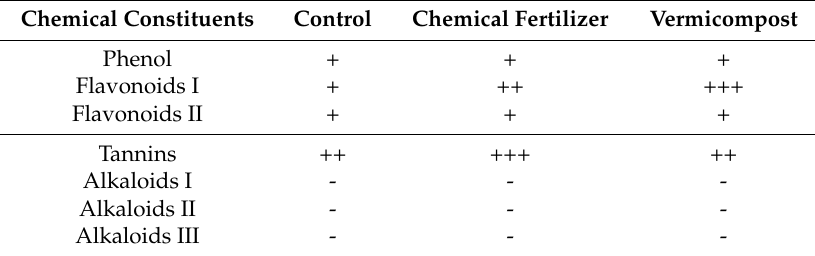
Table 1. Phytochemical analysis of the methanolic extract of MD2 pineapple fruits produced from plants supplied with different types of fertilizers in the field.